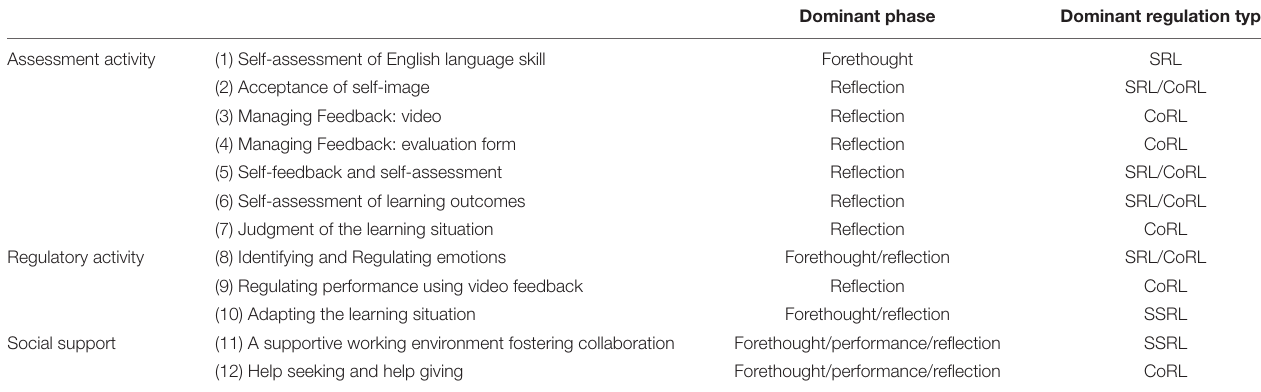
TABLE 2 | Dominant phases and regulation types by category of activity.